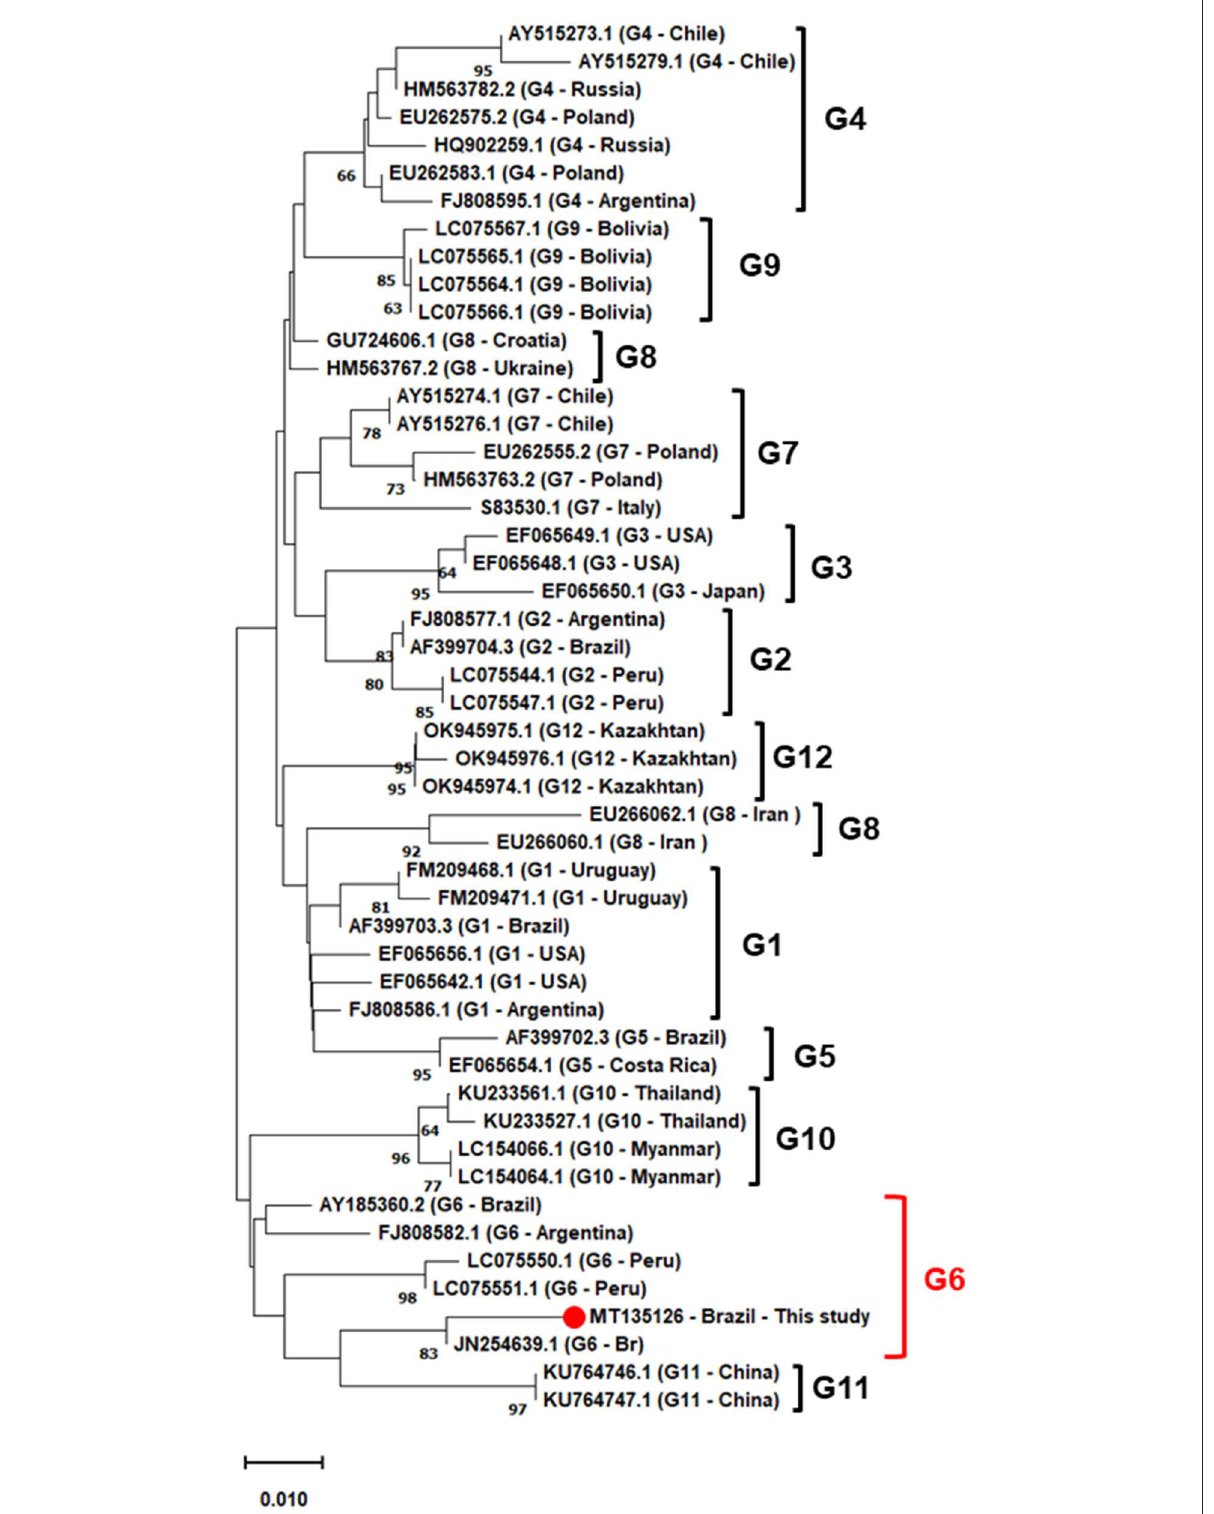
FIGURE2 Phylogenetic inferences using the neighbor-joining (NJ) method based on the Kimura 2-parameter model, with gamma distribution (k2 + G), the numbers at the branches show bootstrap support (1.000 replicates). The analysis involved 50 nucleotide env gene sequences from Brazil and the world, based on 464 bp fragment. The sequence described in this study is indicated by filled red circle. Evolutionary analyses were conducted in